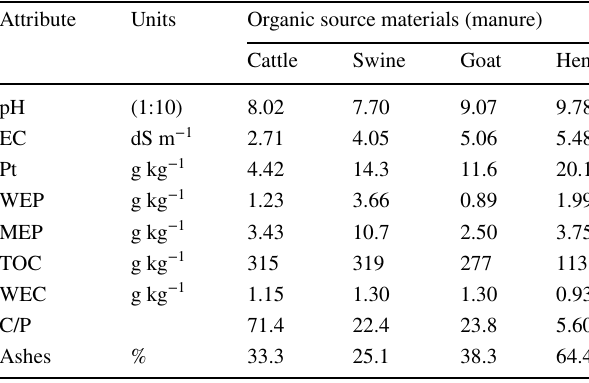
Table 4 Chemical analysis of organic sources used in experiments with soil